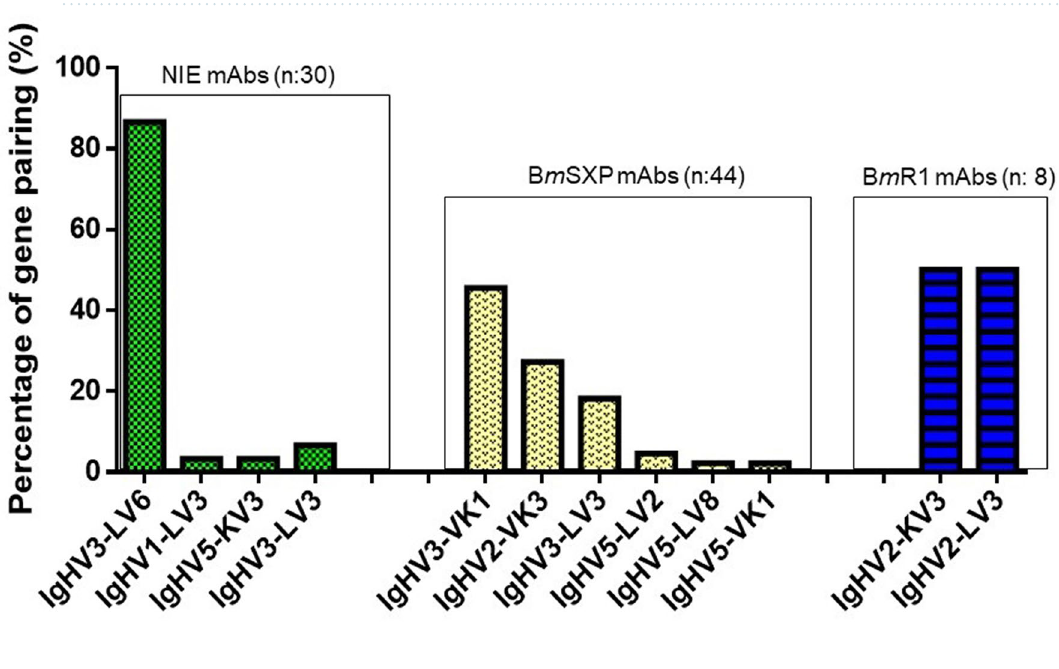
Figure 2. Analysis of gene pairing frequency of isolated of rNIE antigen antibody clones and comparison against previous B. malayi antigens antibodies (B m R1 and B m